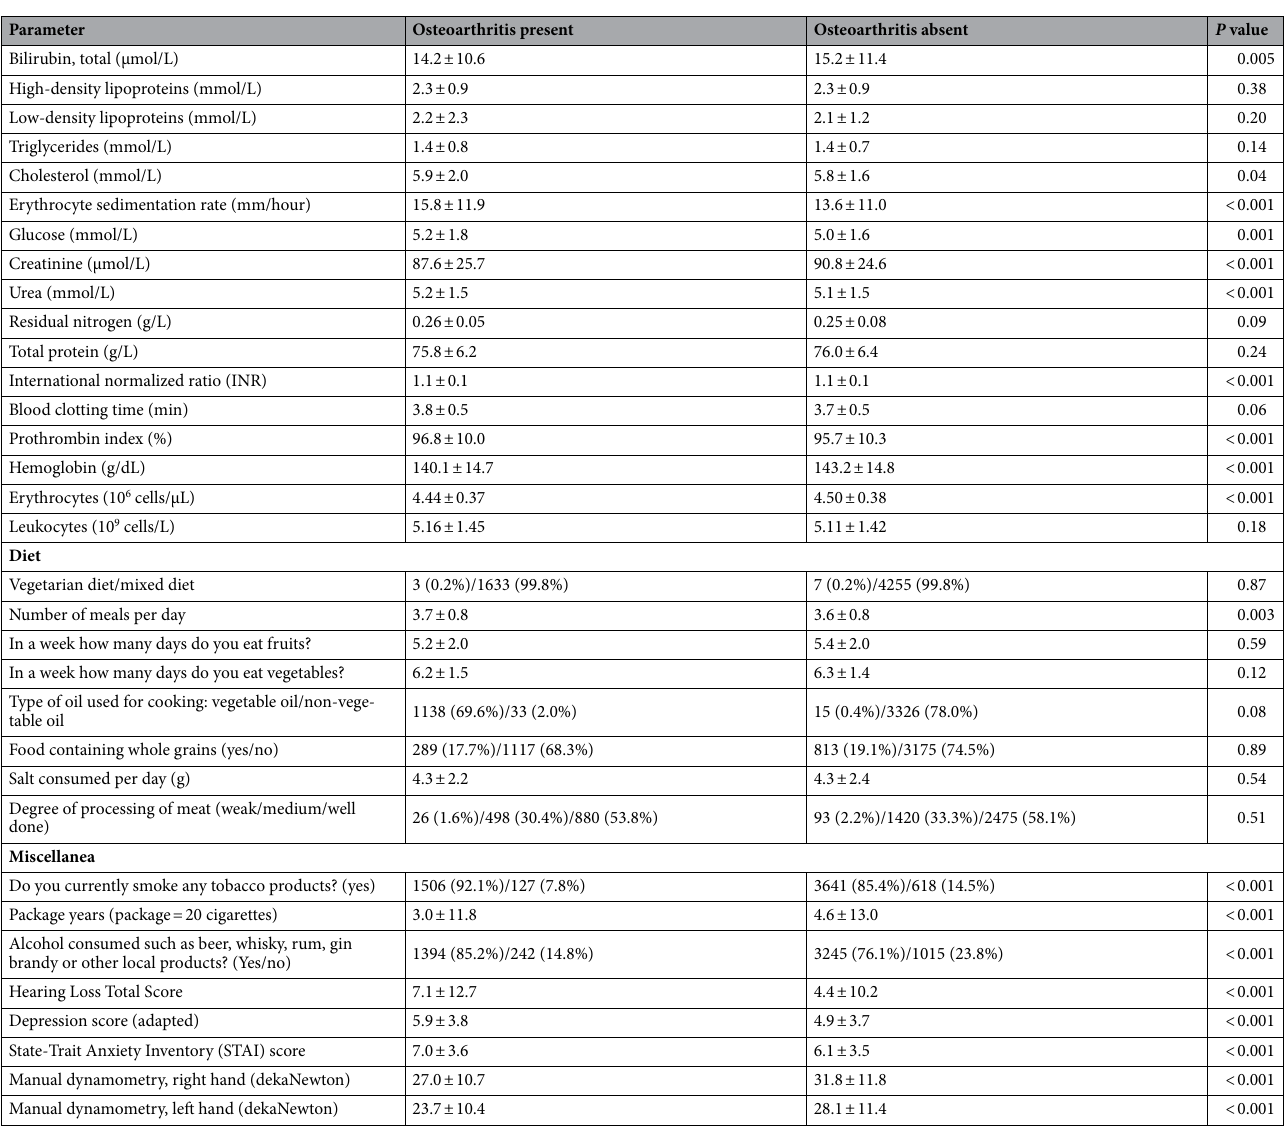
Table 2. Demographic parameters of the population of the Ural Eye and Medical Study, stratified by the presence of